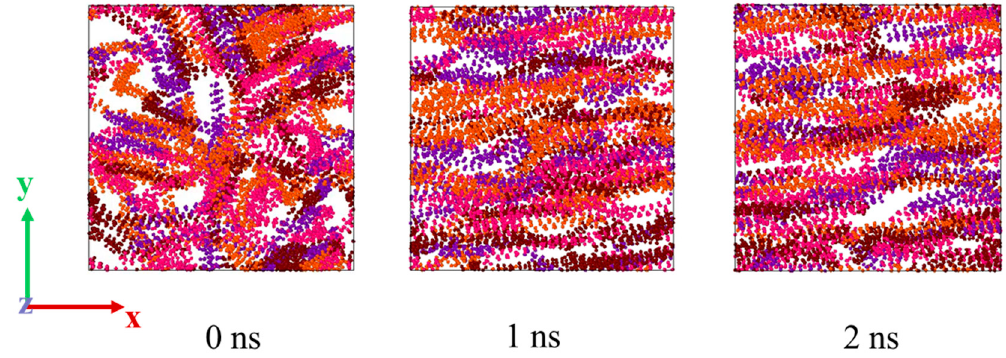
Figure 7. Microscopic behavior of wax molecules at a shear rate of 0.1 ps − 1 at 293 K.